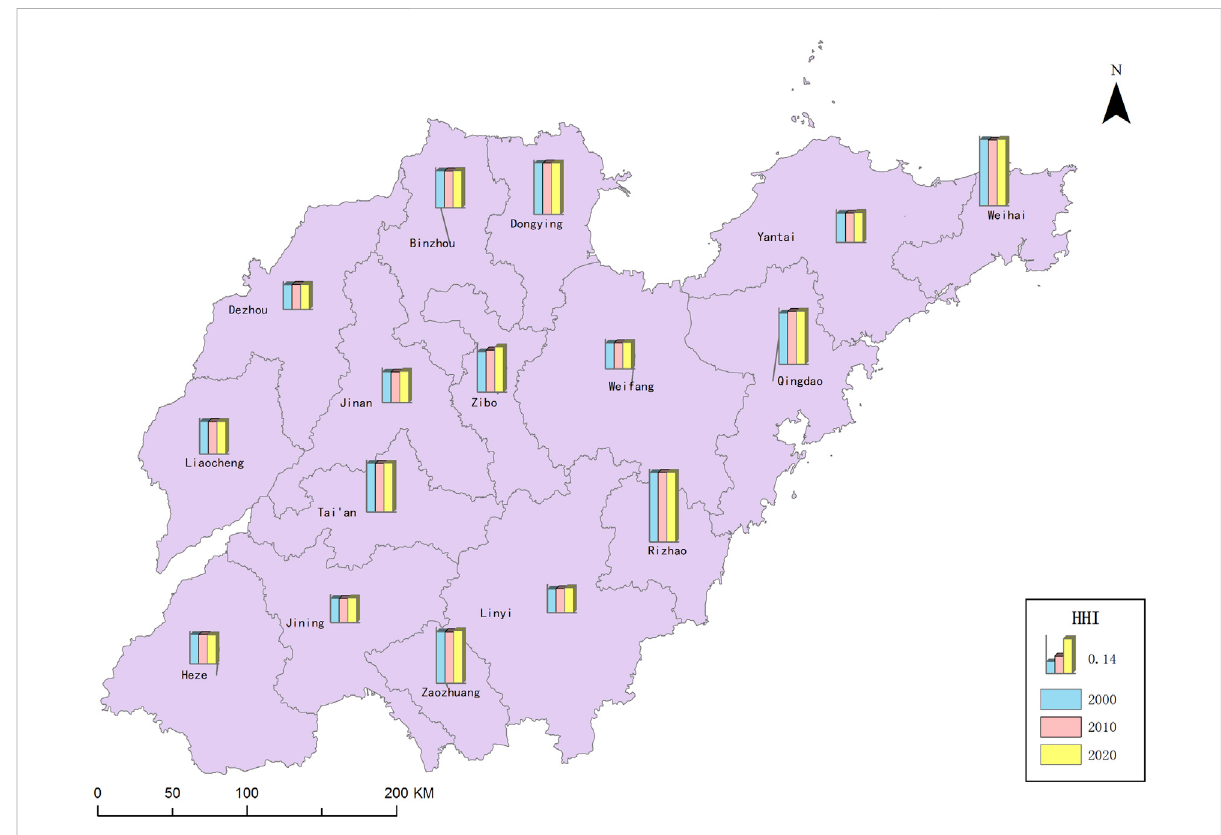
FIGURE 2 Spatial distribution concentration index of cultivated